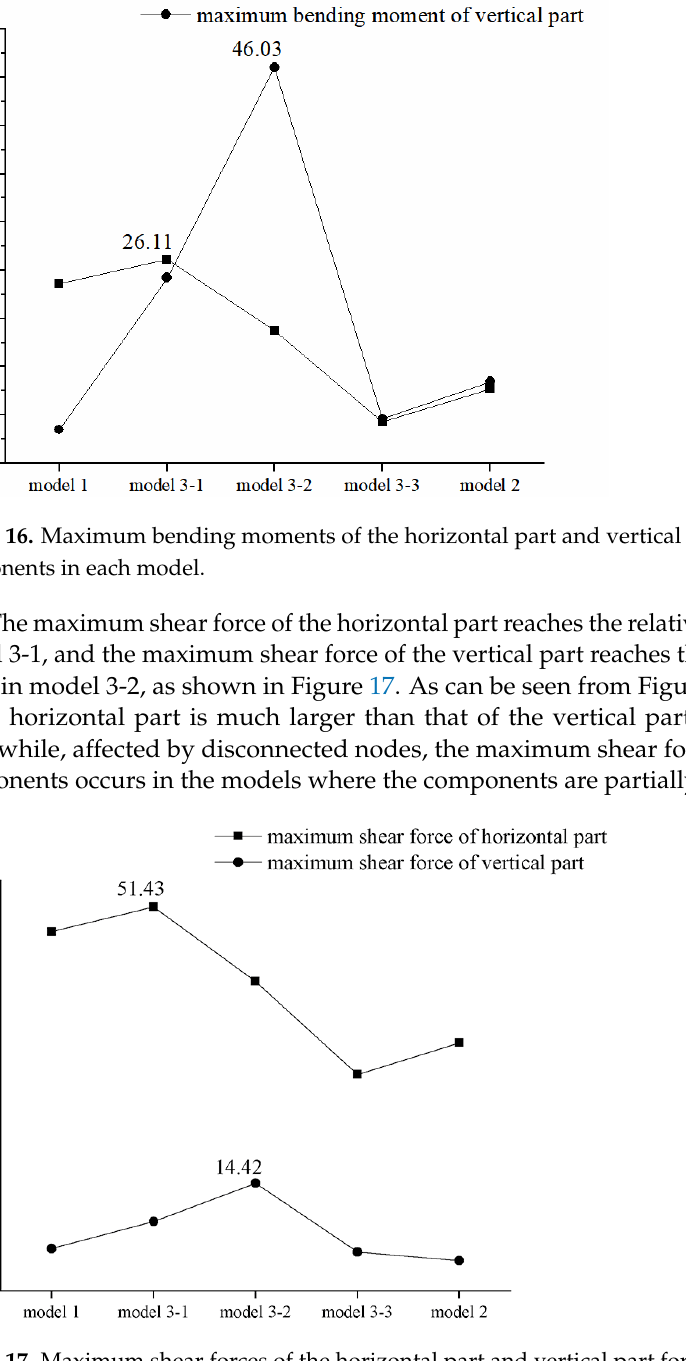
Figure 17. Maximum shear forces of the horizontal part and vertical part for the sH-shaped compo- nents in each model. Torque of the horizontal part: only the horizontal parts of sH 1-2 have torque. Torque of the vertical part: In model 1, the torque value of the vertical part of each component remains the same from top to bottom; in the remaining four models, there are sH-shaped components completely disconnected from the adjacent components on the same floor, and the torque of their vertical part is zero. For the remaining components, the torque values of the vertical part also remain the same from top to